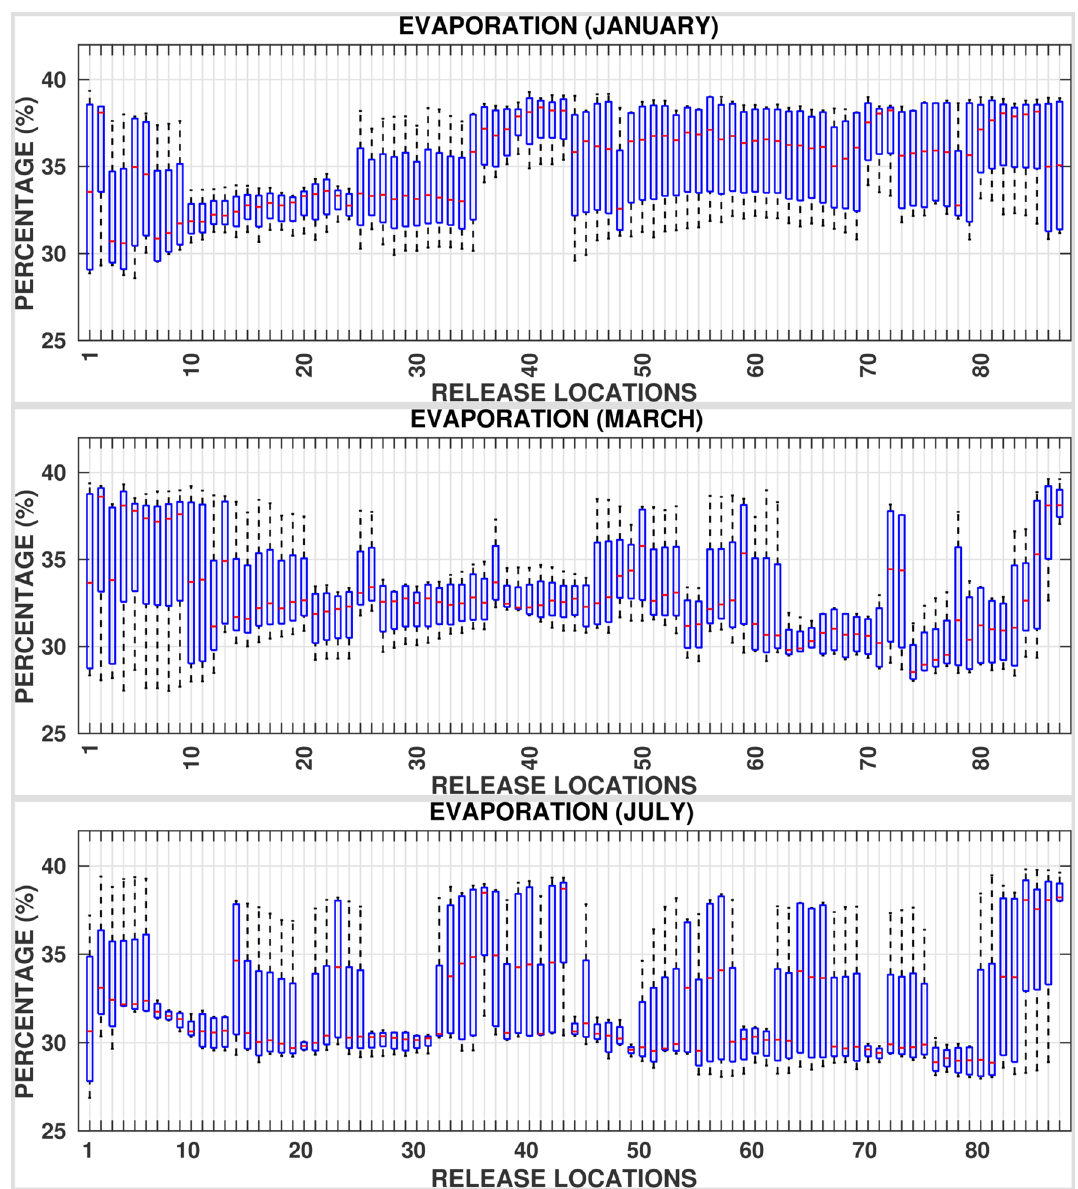
Figure 9. Percentages of oil evaporated, twenty (20) days after the commencement of the spill for each release location ( RL i : i = 1 : 87 ) for all the 4 years considered in